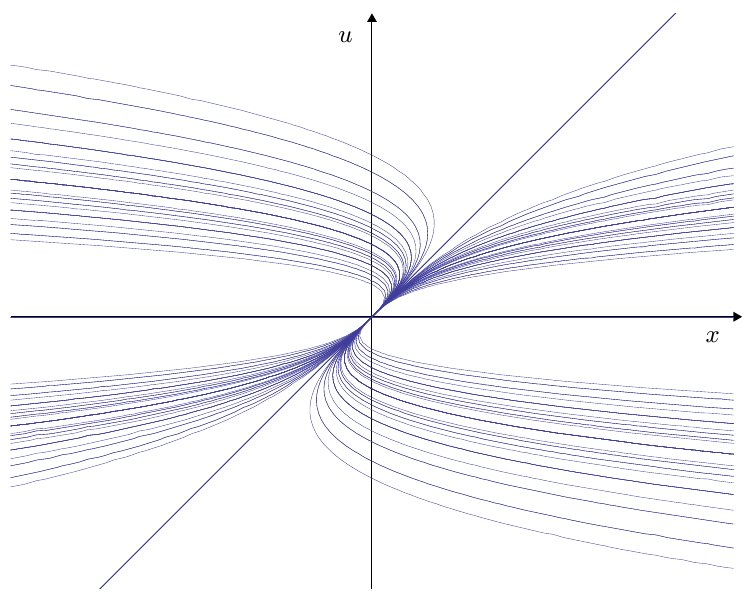
Fig. 2. Solutions of the equation (3 x − 2 u ( x )) u ′ ( x ) = u ( x )